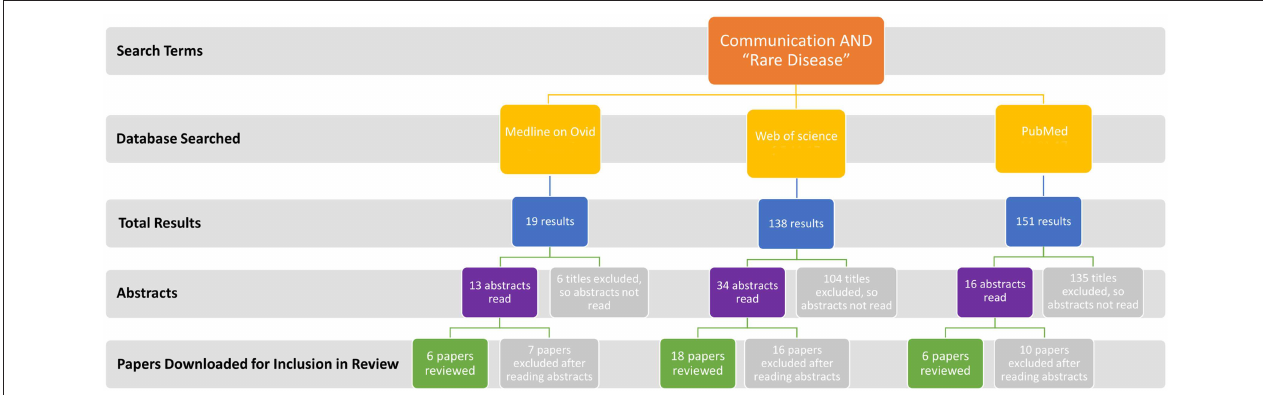
FIGURE 1 | Flow chart illustrating literature review process where 30 full text articles were included in the final analysis. Papers were excluded after review of abstracts as they were: not focused on rare disease; not to do with the topic of communication; about medical issues directly rather than the communication around them; not in English; published prior to 2012; to do with animals rather than humans; not relevant to person to person communication (genetic communication for example); about research practice rather than how to access research; related to achieving diagnosis rather than what is communicated around it; about symptoms which make communication difficult rather than communication about the rare